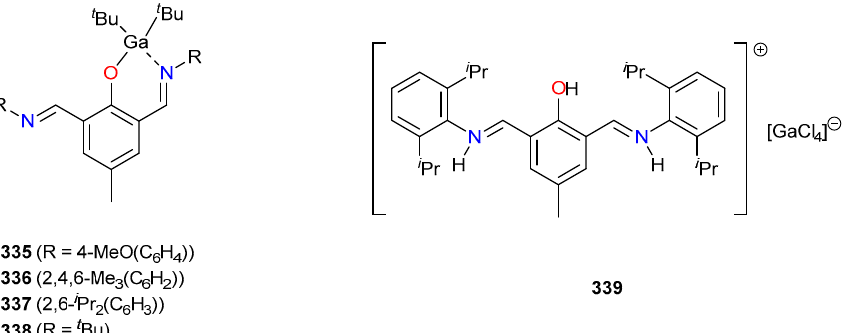
Figure 50. Ga-based catalyst 326–334 [124,141].